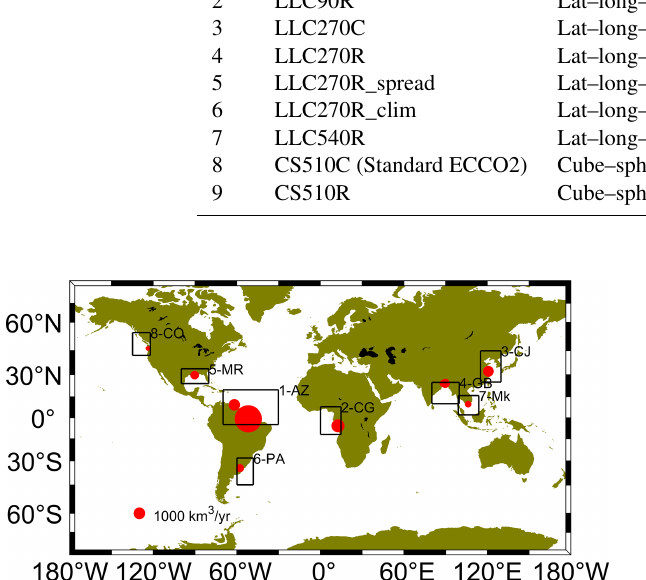
Figure 1. The 10 large rivers (red circles) at 8 coastal regions (black boxes) used in our analysis: Amazon and Orinoco (South America, noted as region 1), Congo (Africa, region 2), Changjiang (Asia, region 3), Ganges and Brahamptura (Asia, region 4), Missis- sippi (North America, region 5), Parana (South America, region 6), Mekong (Asia, region 7), Columbia (North America, region 8). Red circle size is scaled by the climatological river discharge